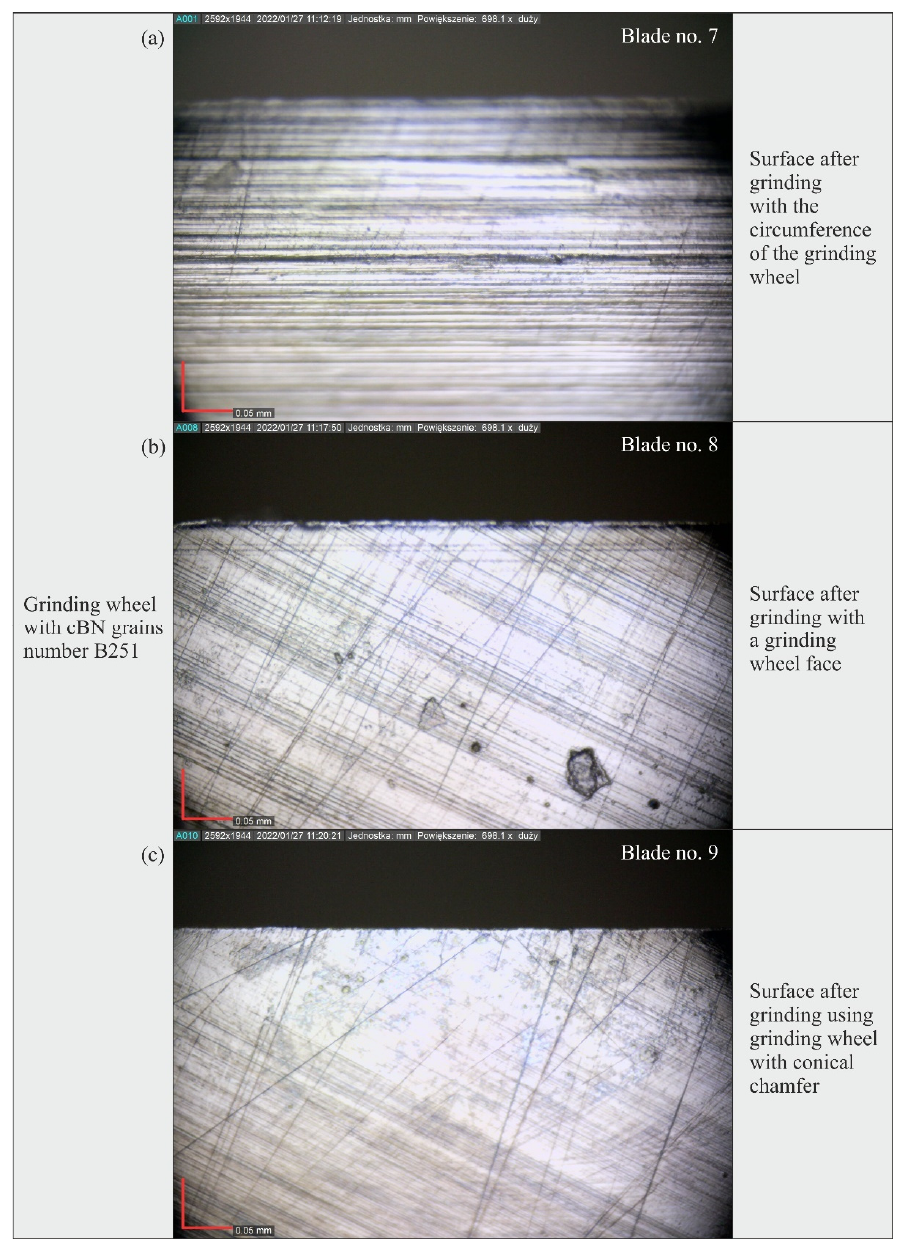
Figure 21. Microscopic views of the blade surface of planar knives shaped using grinding wheels with cBN abrasive grains numbered B251 at a magnification of approximately 700×: ( a ) surface after peripheral grinding (blade no. 7); ( b ) surface after face grinding (blade no. 8); ( c ) surface after grinding using grinding wheel with conical chamfer (blade no. 9).